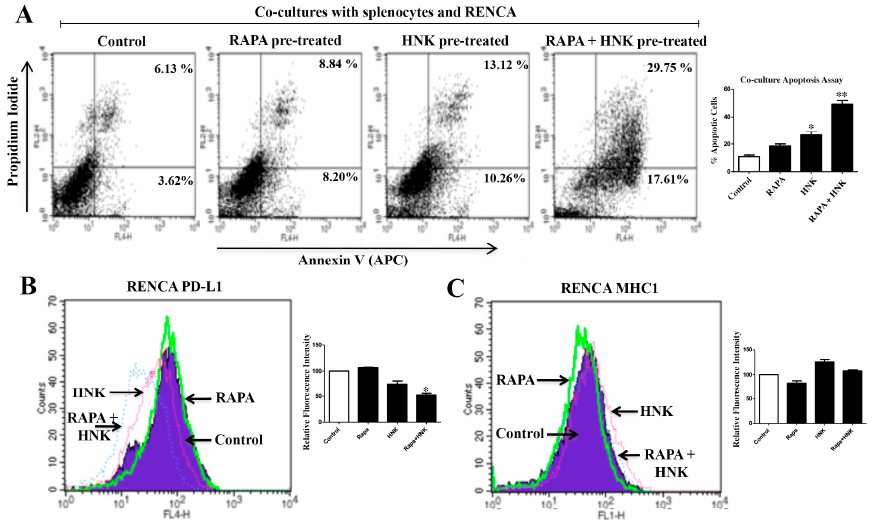
Figure 7. Honokiol (HNK) potentiates immune cell ‐ mediated killing on renal cancer cells. ( A )